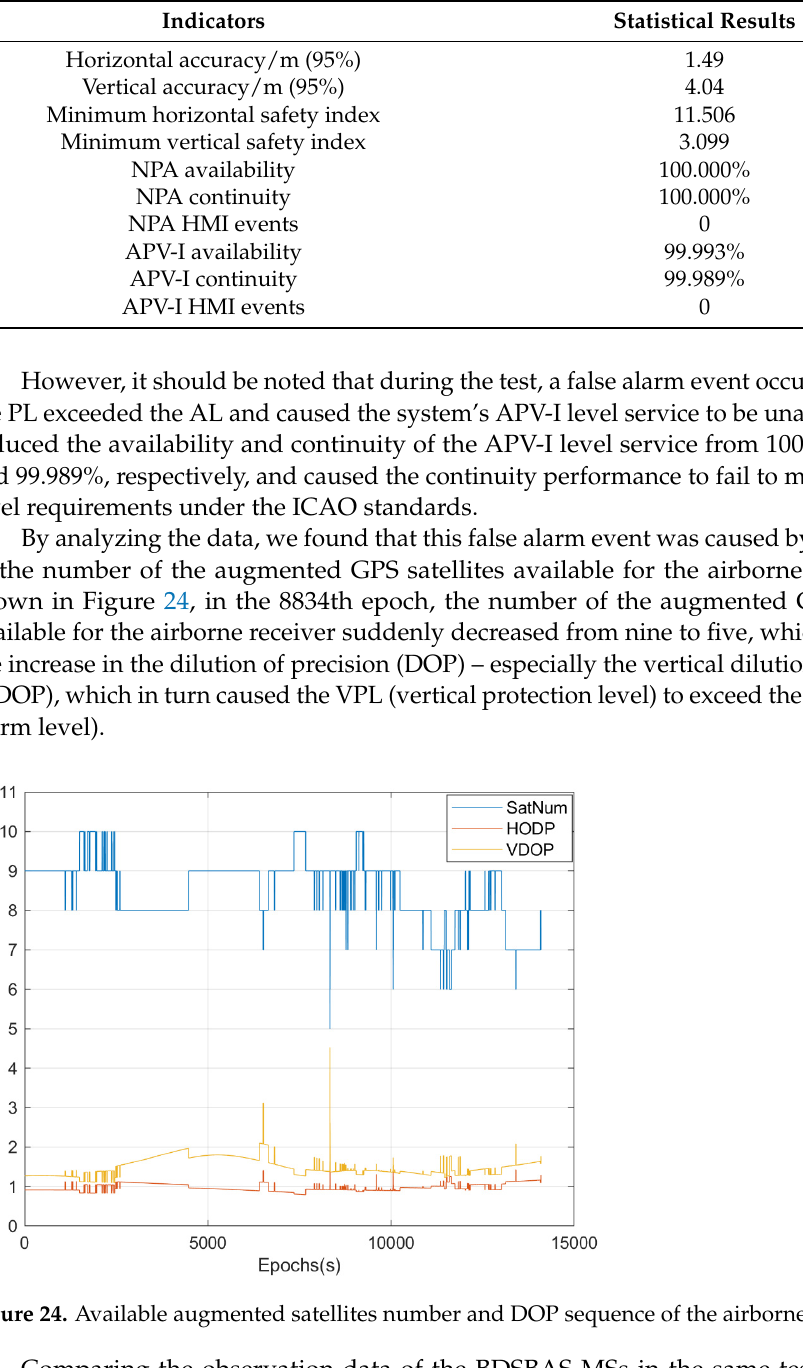
Table 4. BDSBAS SF performance statistics of flight test-III.